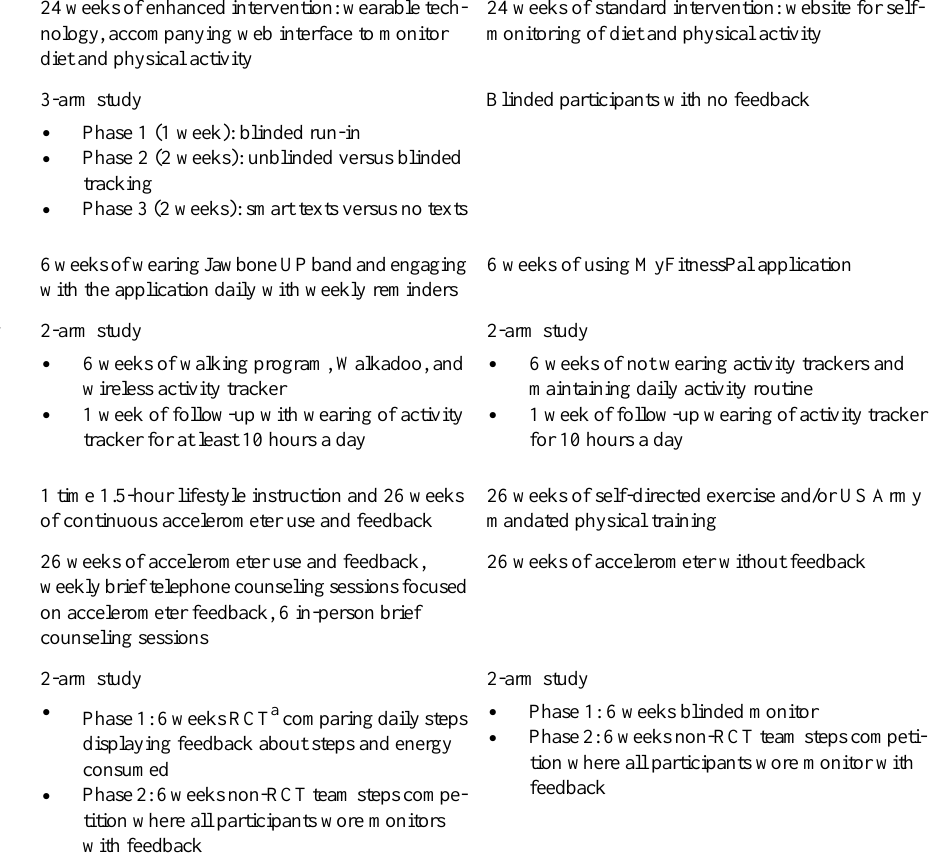
26 weeks: only received health-related information26 weeks of group-based education, social